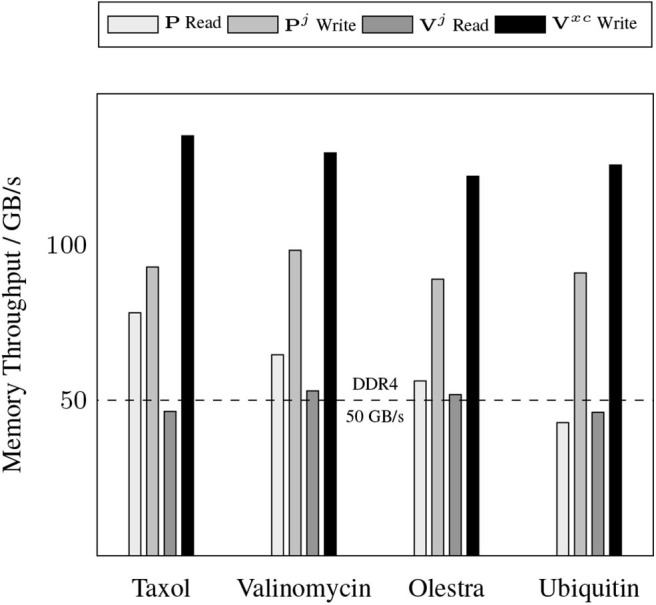
Achieved memory throughput for dominant device-to-device (D2D) data transfers in the XC integration compared to the peak DDR4 bandwidth in host memory.